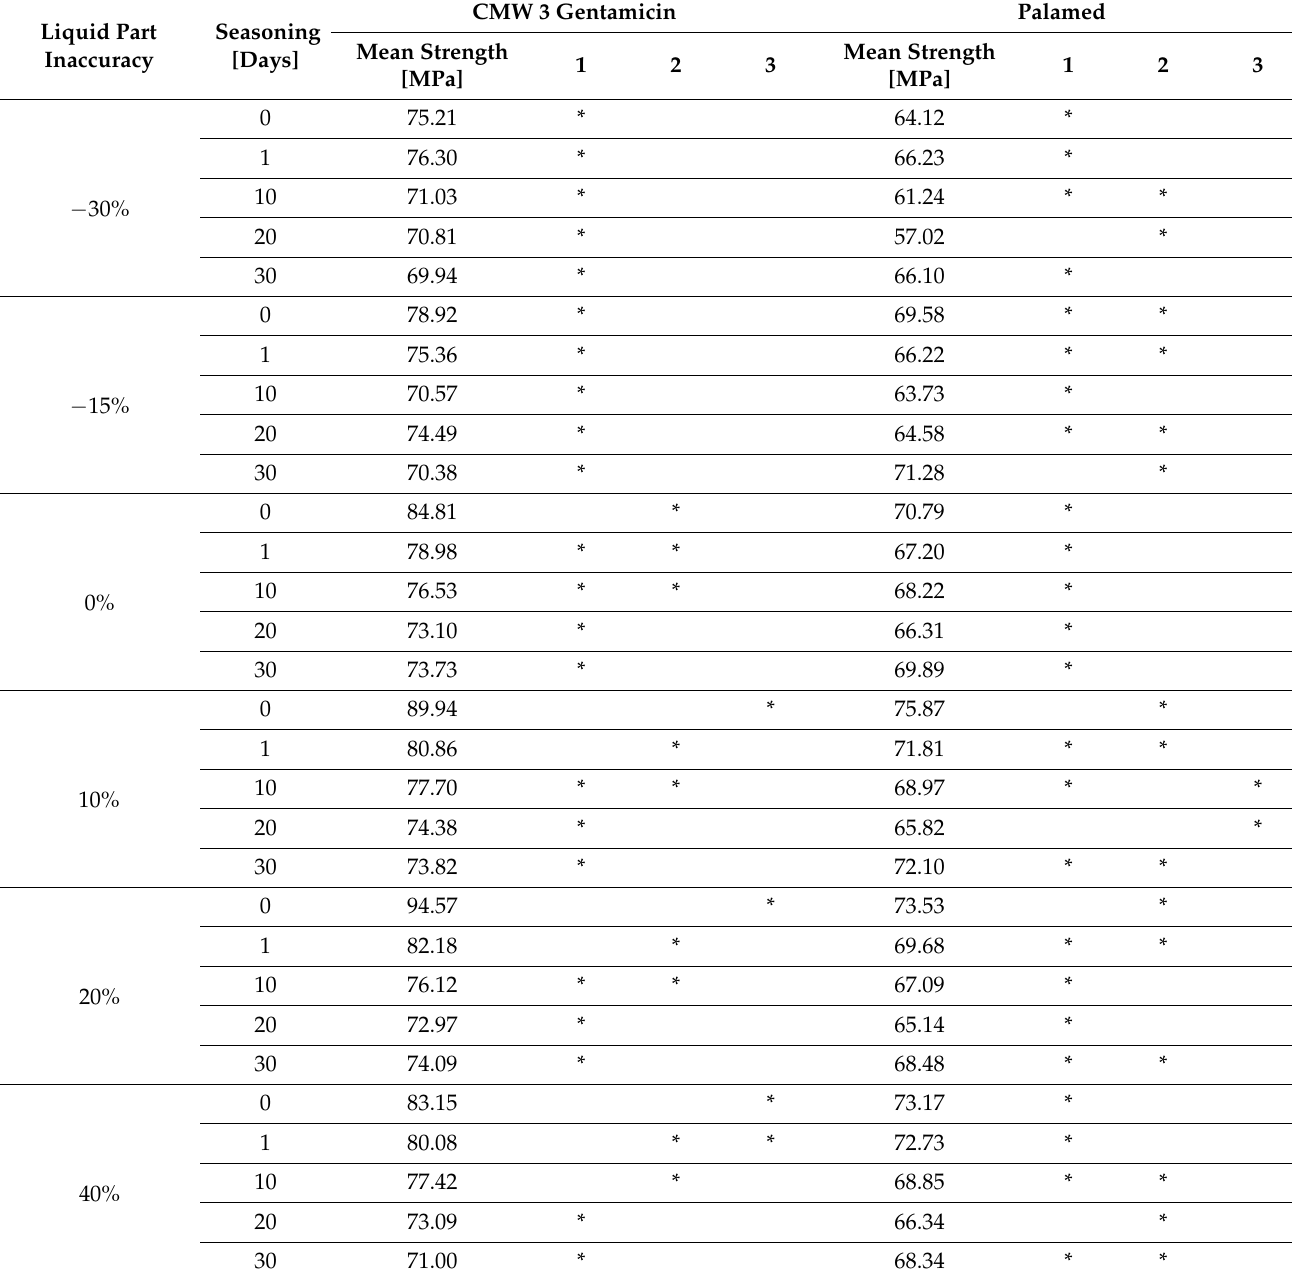
Table 2. Results of statistical analysis of compressive strength test results (*—samples within homo- geneous